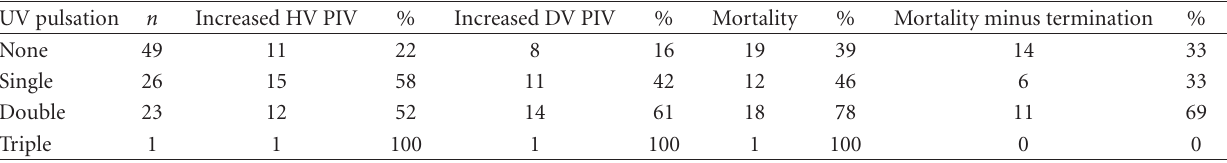
Table 3: Type of umbilical venous pulsations (UV) in relationship to increased pulsatility index for veins (PIV) in the right hepatic vein (HV) and ductus venosus (DV) and mortality. Numbers and percent are